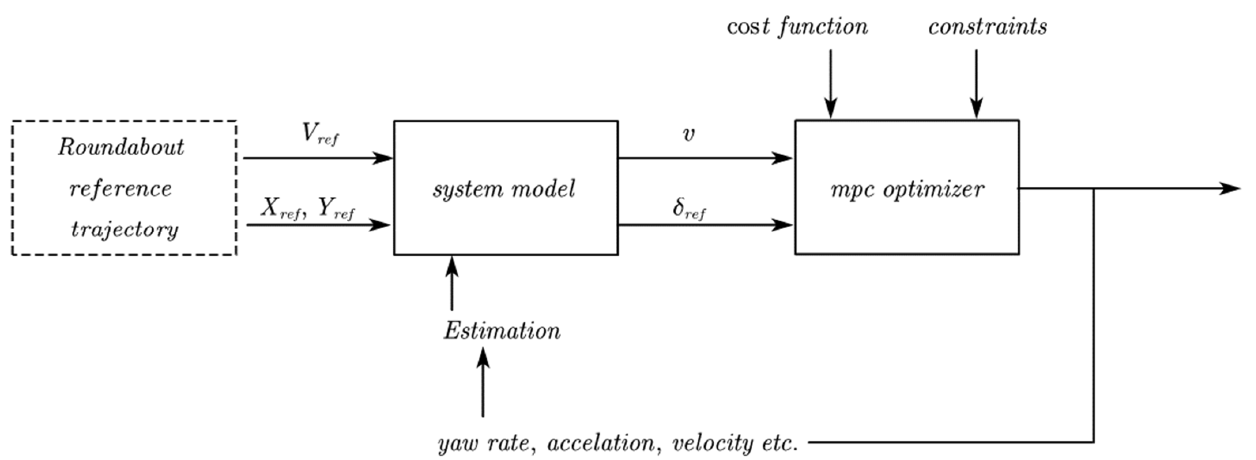
Figure 1. Model predictive control trajectory tracking system scheme.